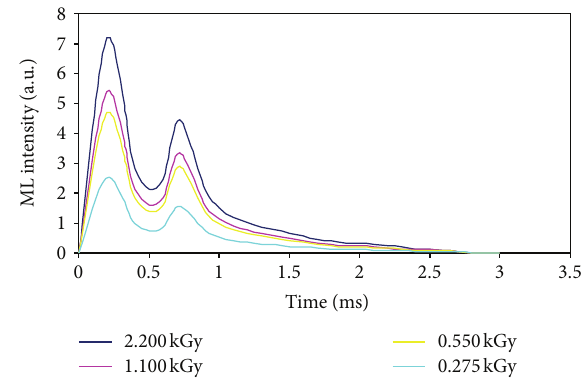
Figure 2: Dependence of ML intensity of MgAl 2 O 4 : Dy (0.1mol%) phosphor on gamma dose.